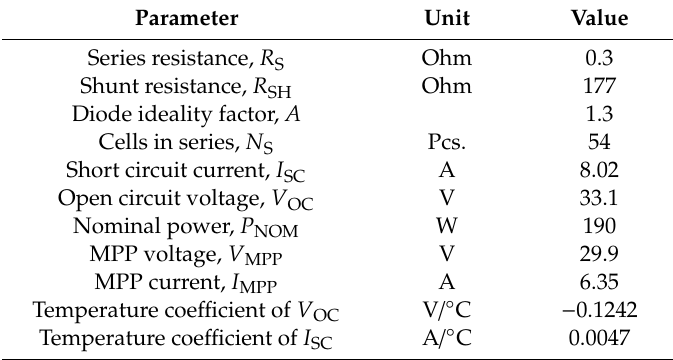
Table 1. Electrical characteristics of the NP190GKg PV panel in STC.